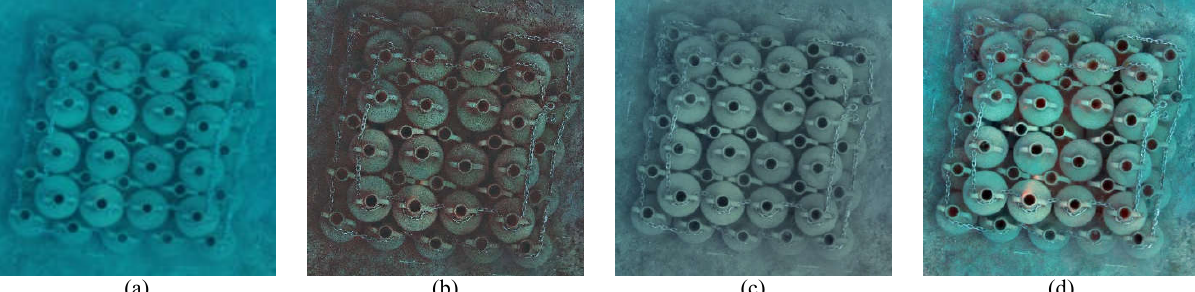
Figure 10. The orthoimage of the deep dataset created by using the original images (a), by correcting the (a) using the CLAHE based algorithm (b), by correcting the (a) using the algorithm of Bianco et al., (2015) (c) and by correcting the (a) using the Adobe Photoshop